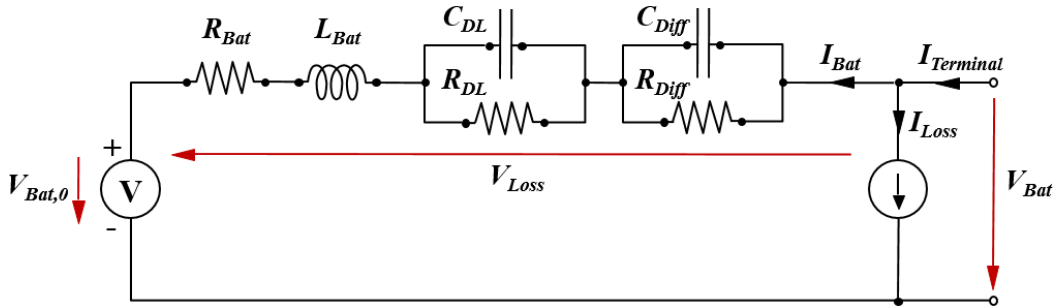
Figure 3. Battery equivalent